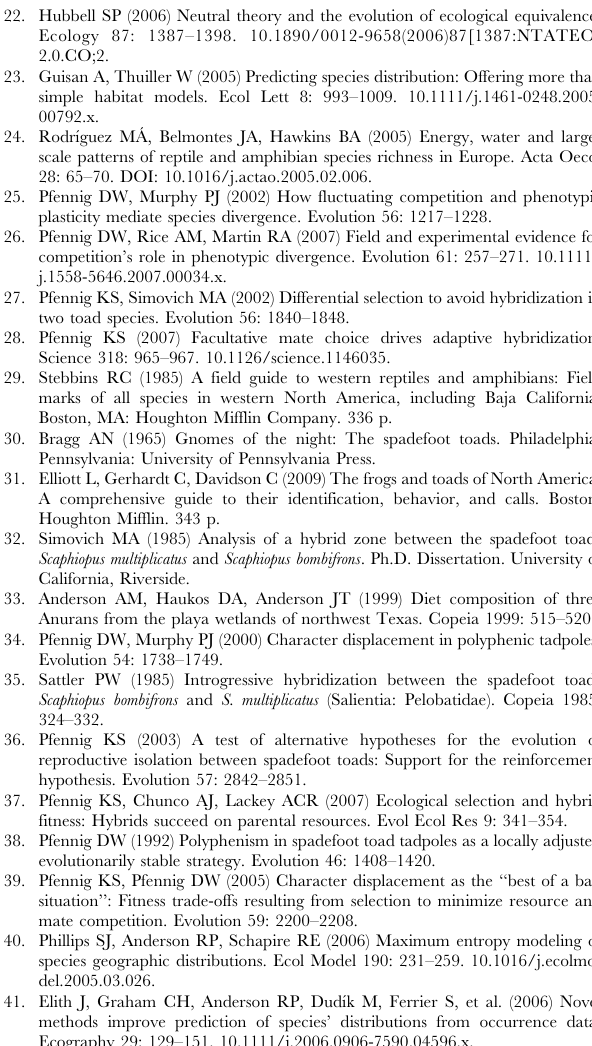
Figure S4 Sensitivity analysis. Maxent model results at four different regularization multipliers: A) 0.1, B) 0.5, C) 2.0, and D) 5.0. Each of these models was run based on the same environmental variables included in the Climate-Only model. Other than the regularization multiplier, all other values were held at default levels. Each map shows the average of 10 replicate runs. Table S1 The following institutions provided locality data used in the ecological niche models. Table S2 Environmental variables used in each M AXENT model. Table S3 Mean and standard deviation for each of the four niche models run.